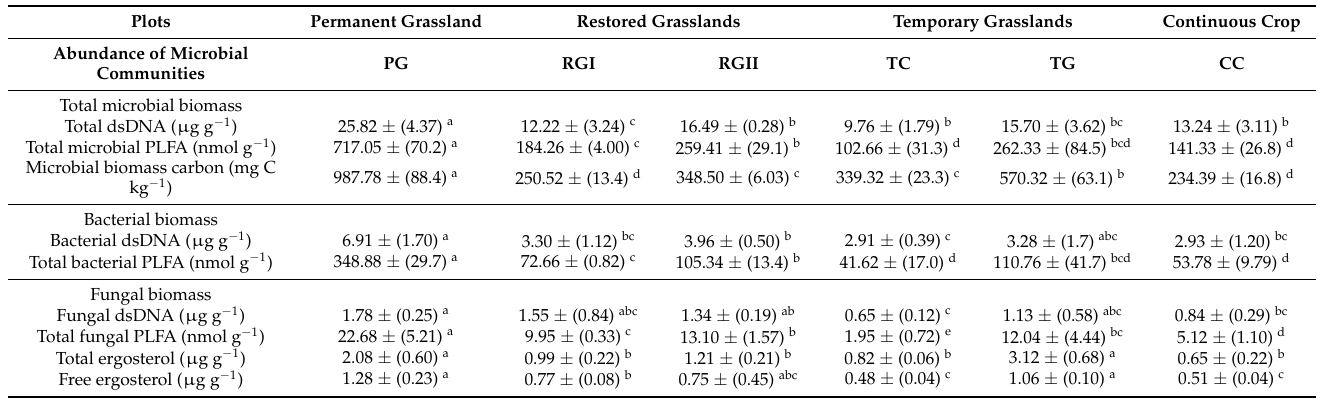
Table 5. Total, bacterial, and fungal biomasses of plots.